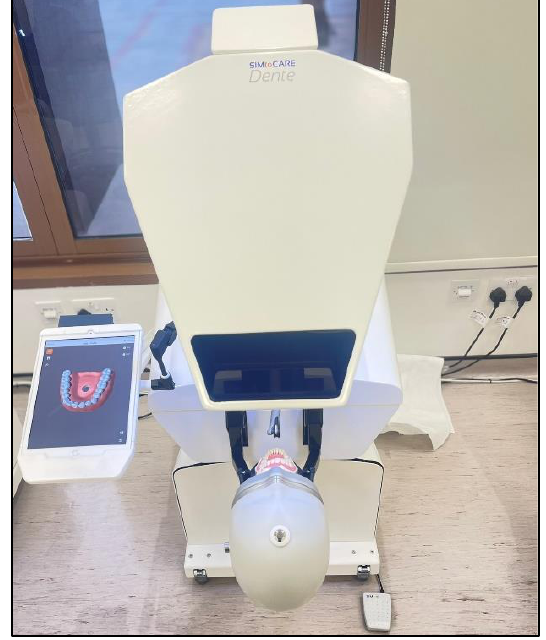
Figure 1. SIMtoCARE Dente ® Haptics Reality Virtual Simulator.